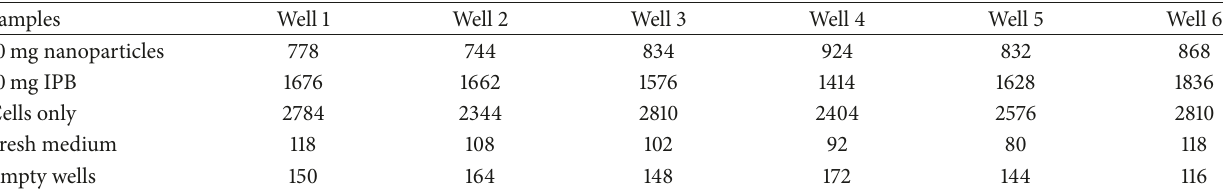
Table 3: Measurement of total cytotoxicity (step 2).